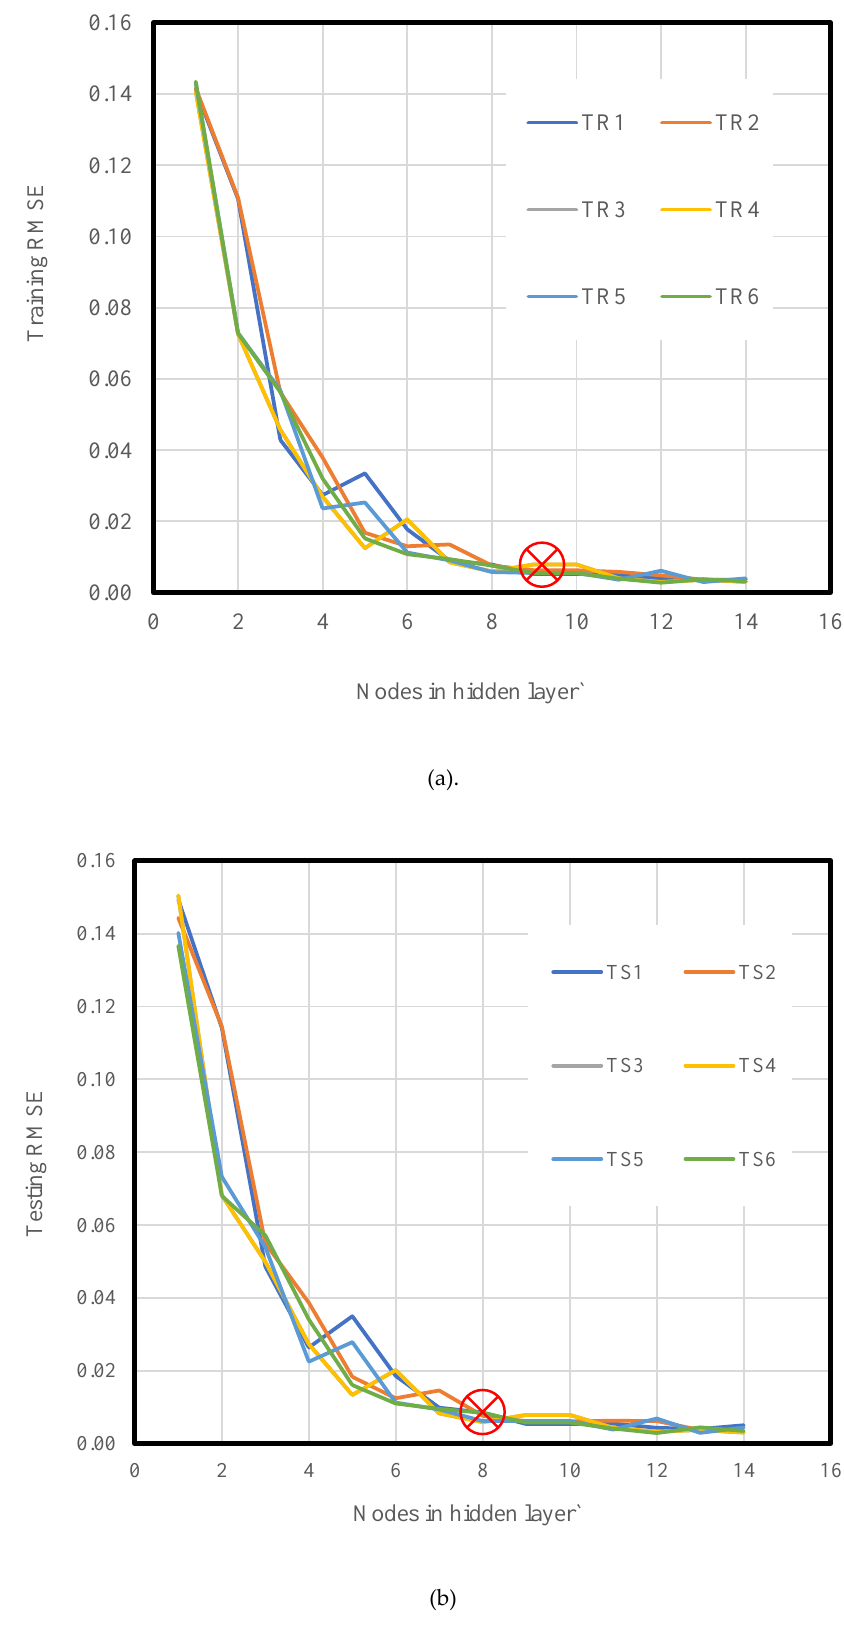
Figure 9. Variation of root mean square error (RMSE) vs. the number of nodes in the estimation of F ult. , ( a ) Training RMSE, ( b ) Testing RMSE